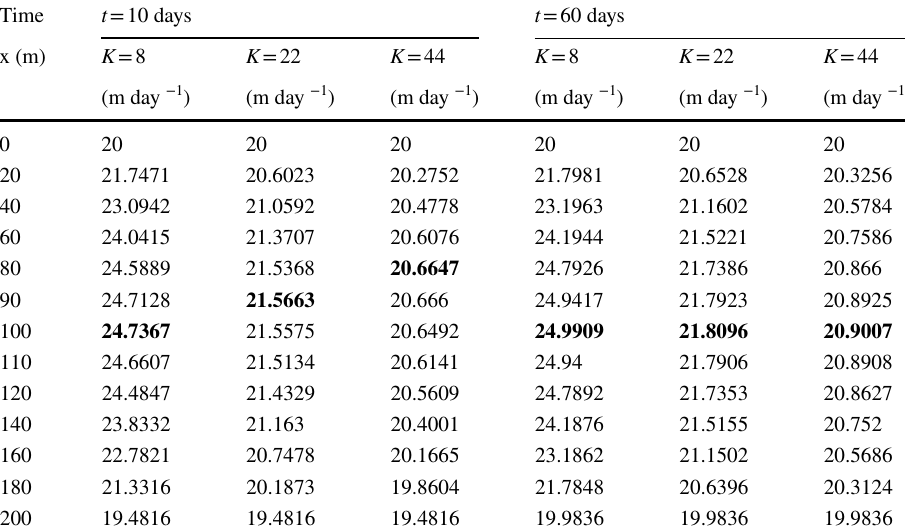
Table 1 The effect of variation in hydraulic conductivity ( K ) on the groundwater hydraulic head at t = 10 days and t = 60 days